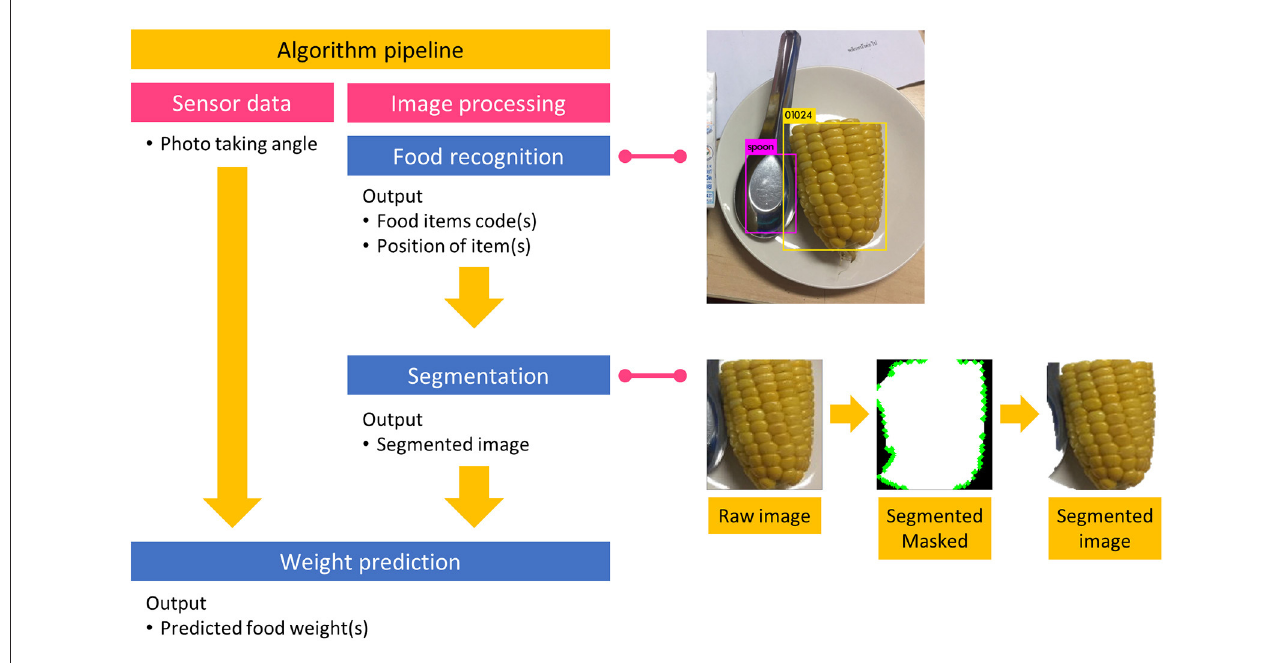
FIGURE 1 | Overview of the